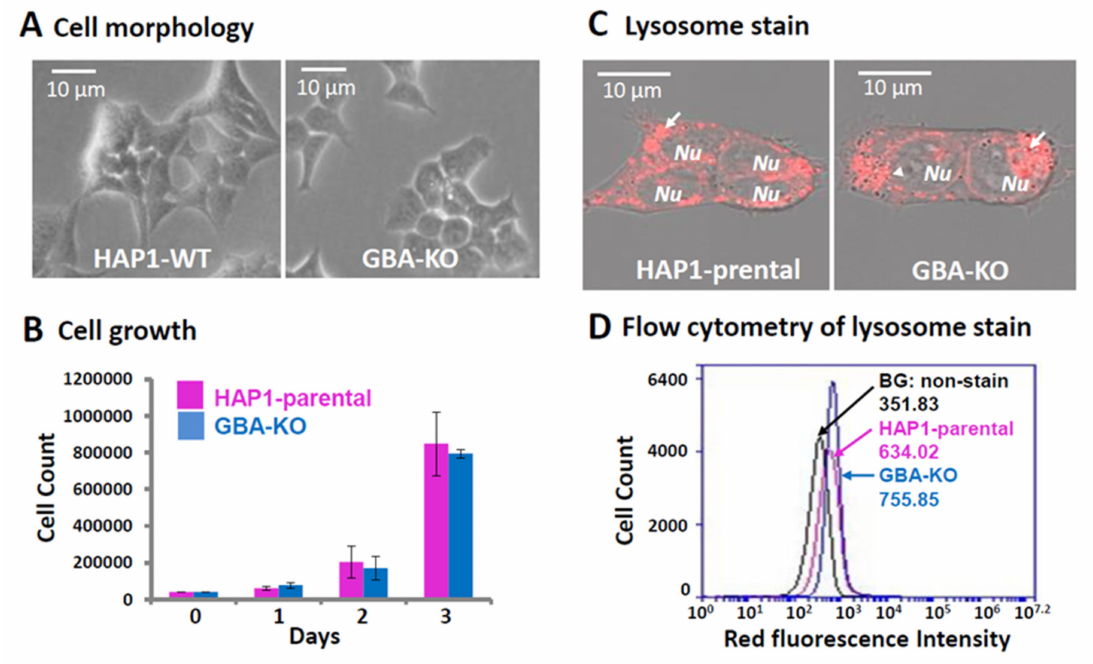
Figure 2. Loss of GBA and the associated changes in the GBA-KO line. ( A ) Live cell images were recorded on the cultured HAP1 and GBA-KO lines. ( B ) The same numbers of cells of either wild-type HAP1 or GBA-KO line were seeded in a 6-well plate (Day 0). The cells were cultured in a complete medium and counted for 3 consecutive days. The cell counts were mean ± standard deviation ( n = 3). ( C ) Cells that were revived and cultured for at least two passages were stained and imaged by a confocal microscope in the wild-type and GBA-KO lines. The lysosome staining images are overlays of fluorescent and transmitted light images using a confocal microscope (magnification of 400 × ). Lysosomes were red granules in the cytosolic compartment of both cultured HAP1 lines. ( D ) Flow cytometry analysis showed that the red fluorescent intensity was elevated to 755.85 in the GBA-KO line, as compared to 634.02 in the wild-type HAP1. The background red florescence was 351.83 in the unstained HAP1